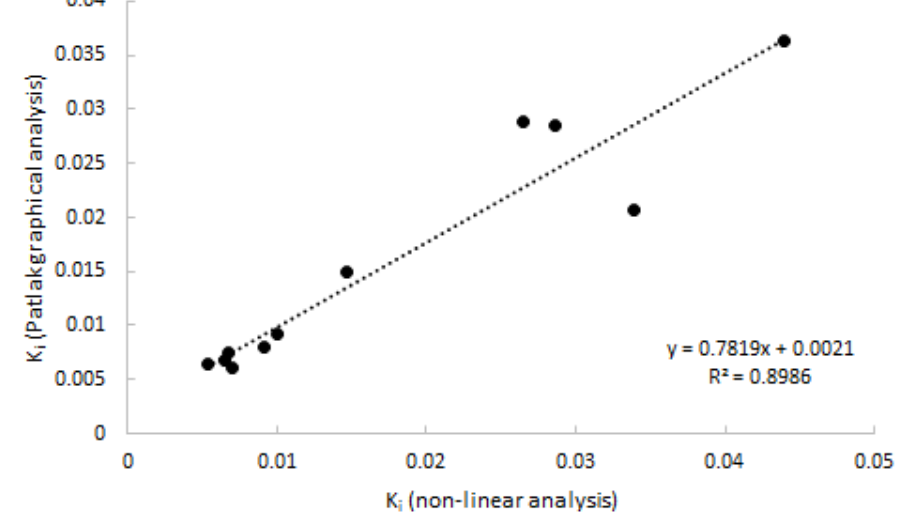
Figure 5. Correlation of K i estimated using Patlak graphical analysis vs. K i estimated using non-linear analysis. Data consist of both clinically affected and non-affected joints.